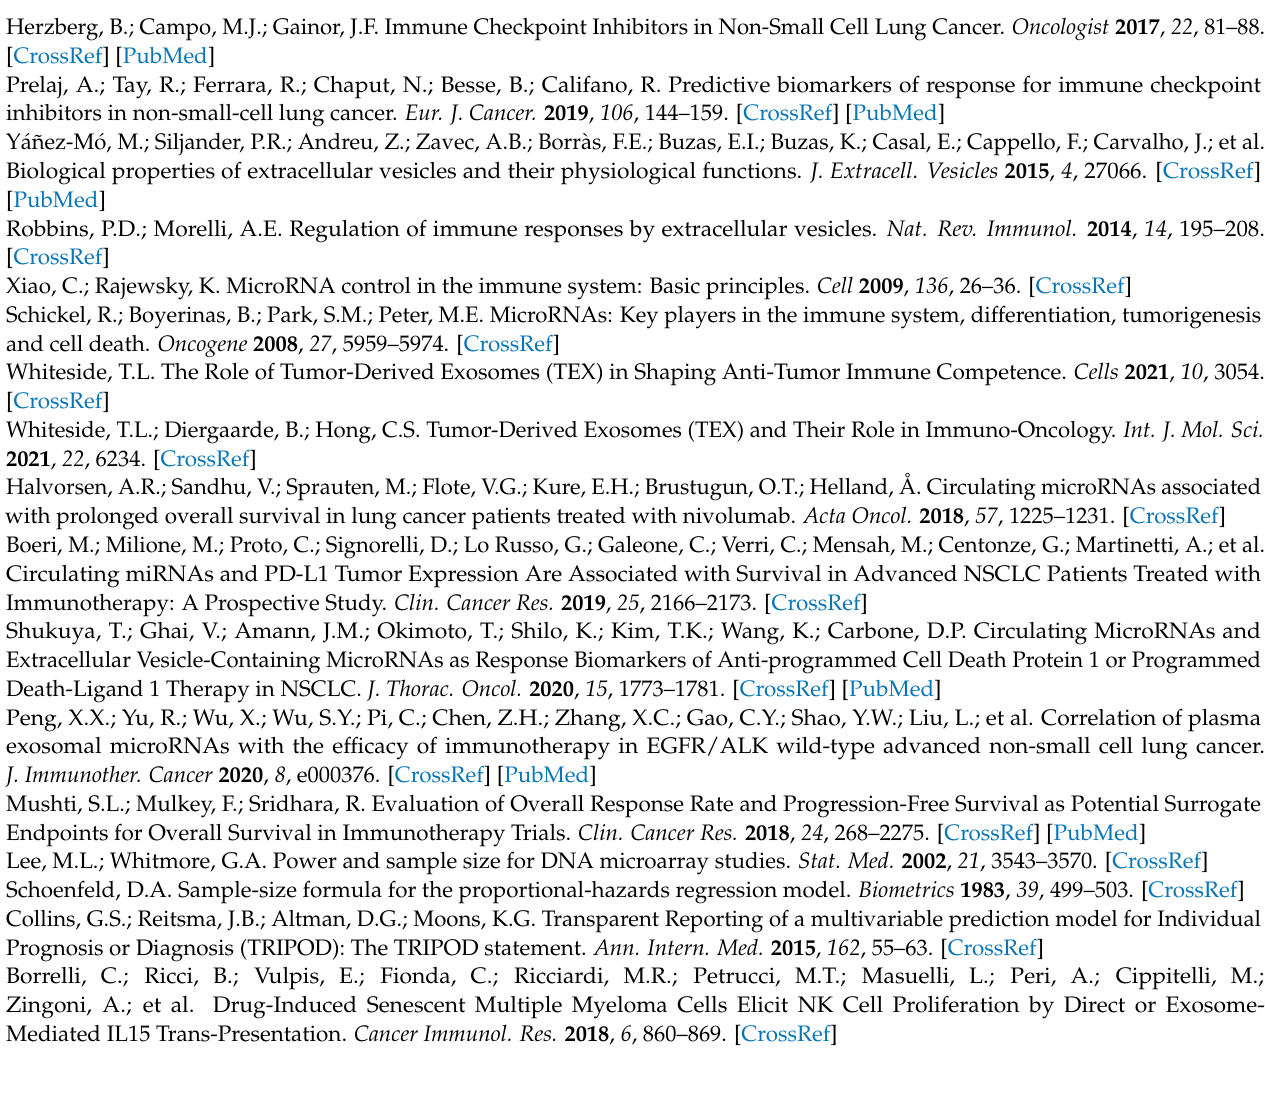
variables; Table S5: Table representing univariate analysis of nonsignificant variables for OR; Table S6: Table representing univariate analysis of nonsignificant variables for